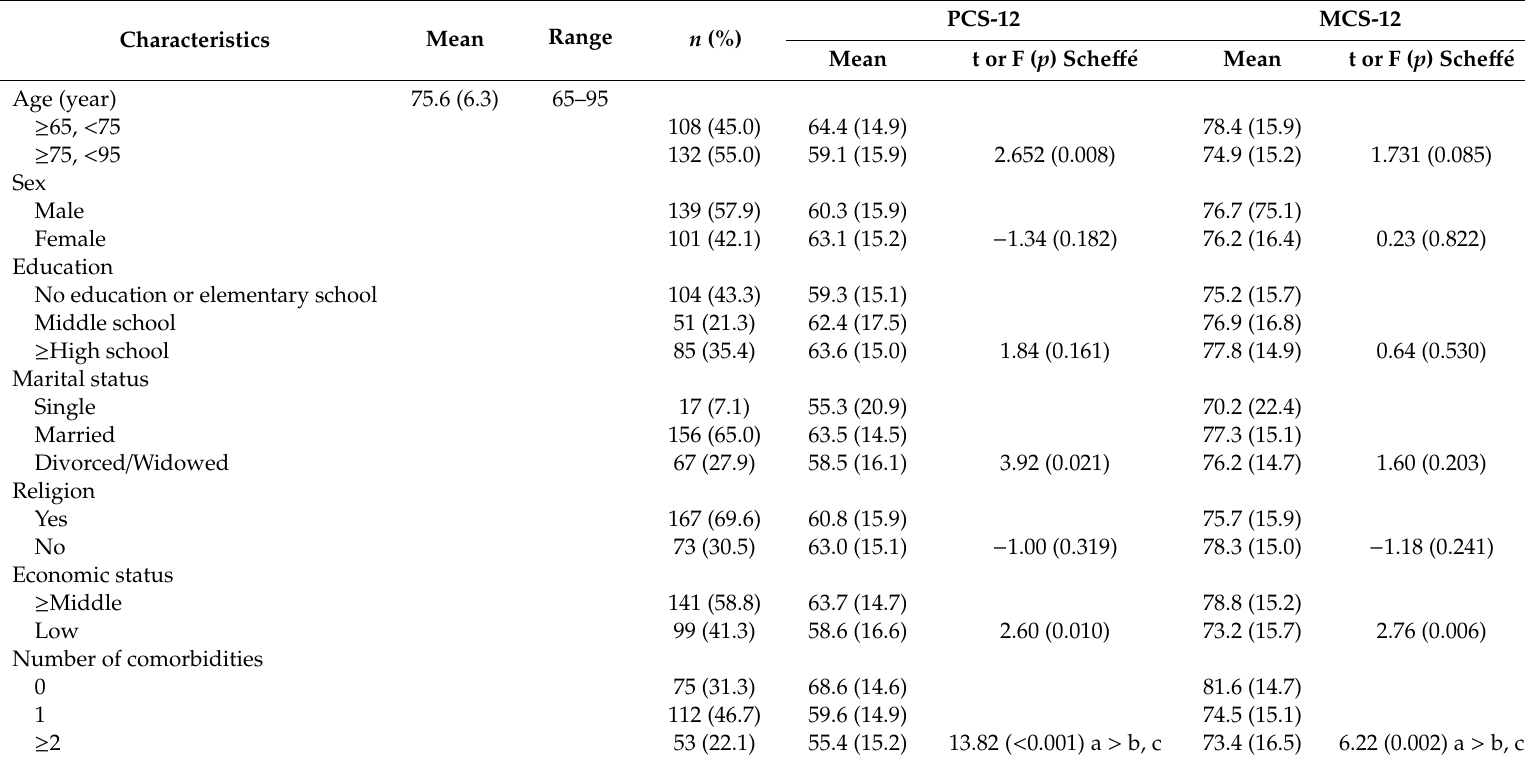
Table 1. Descriptive statistics of participants’ general characteristics and di ff erences ( N =